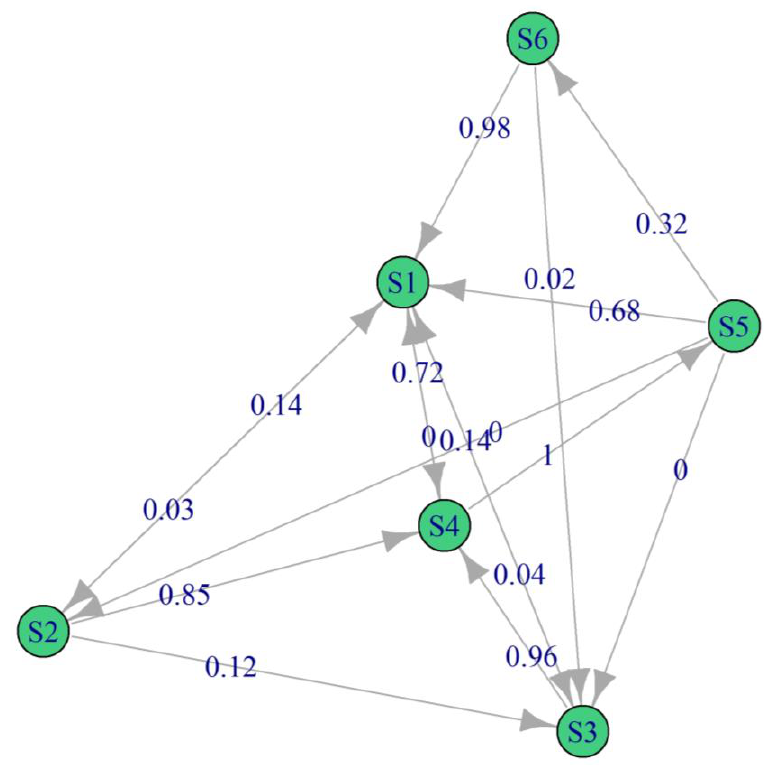
Figure 1. Diagram of the inter-state transitions of the process studied